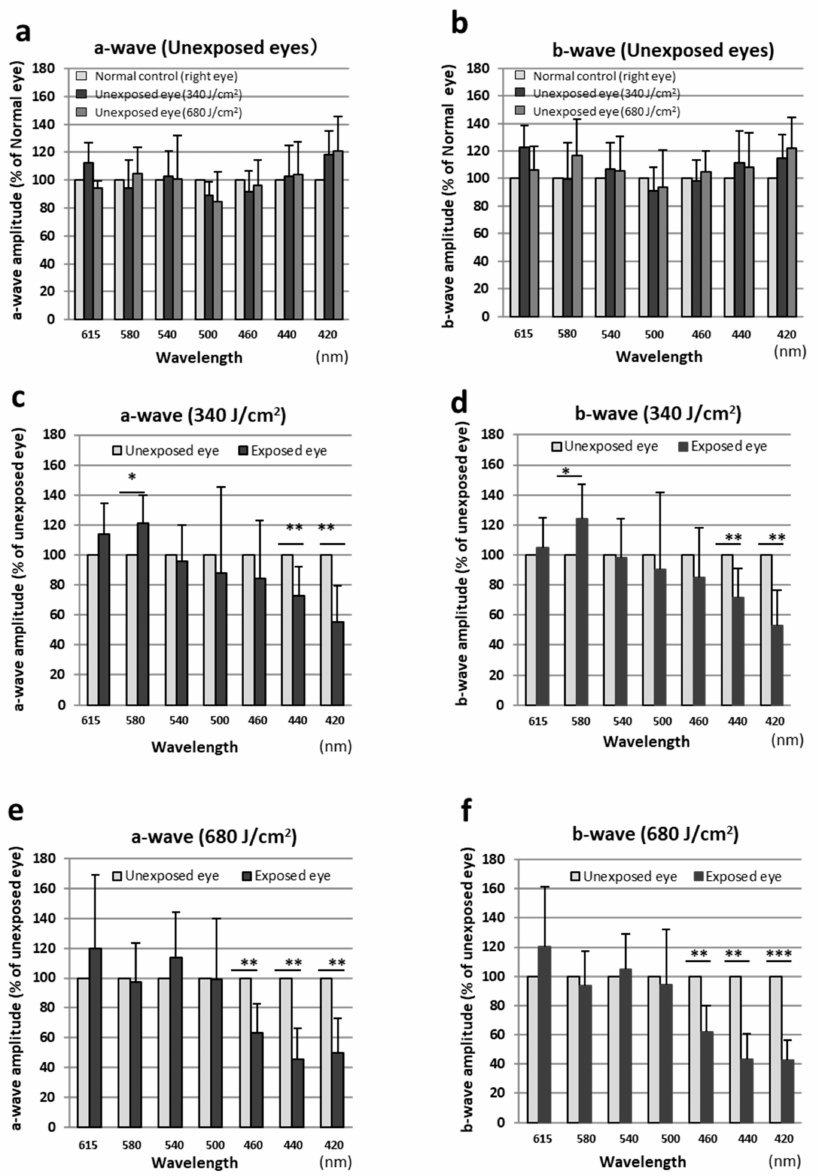
Figure 1. Measurement of retinal function by electroretinography. Data were expressed as mean ± SD. ( a ) The a-wave amplitude (% of the amplitude in normal control right eyes) for unexposed right eyes. ( b ) The b-wave amplitude (% of the amplitude in normal control right eyes) for unexposed right eyes. ( c ) The a-wave amplitude (% of the amplitude in unexposed right eyes) for eyes exposed to 340 J/cm 2 light. ( d ) The b-wave amplitude (% of the amplitude in unexposed right eyes) for eyes exposed to 340 J/cm 2 light. ( e ) The a-wave amplitude (% of the amplitude in unexposed right eyes) for eyes exposed to 680 J/cm 2 light. ( f ) The b-wave amplitude (% of the amplitude in the unexposed right eyes) for eyes exposed to 680 J/cm 2 light. Both eyes were compared using the paired t -test, and between-group comparisons were performed using the unpaired t -test. * p < 0.05, ** p < 0.01, *** p < 0.001. n = 6 in each